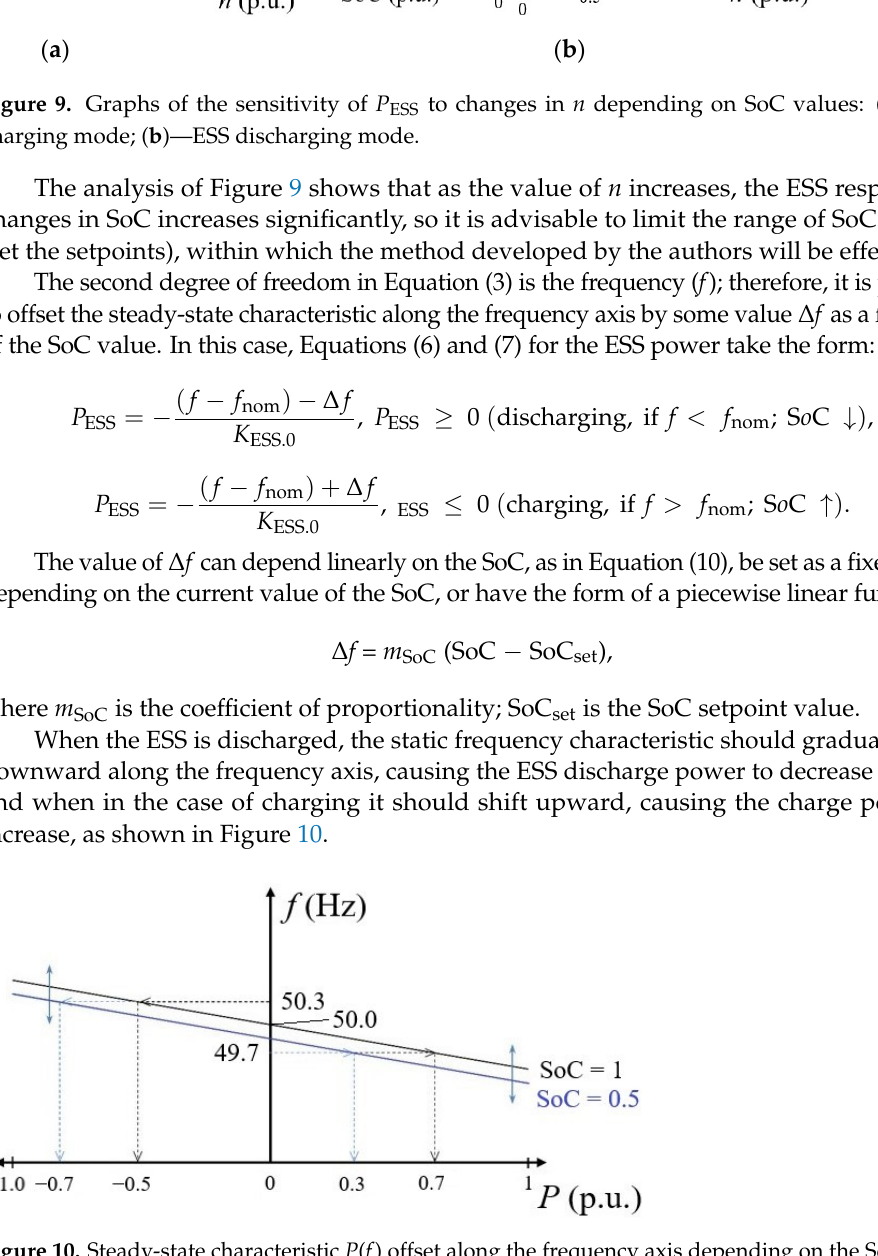
Figure 10. Steady-state characteristic P ( f ) offset along the frequency axis depending on the SoC value of the ESS.